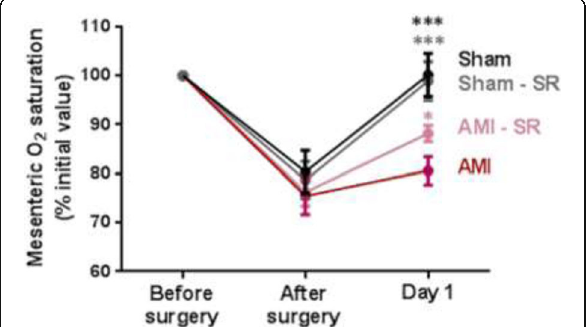
Fig. 1 (abstract 0008). Effect of AMI on mesenteric oxygenation (% of basal value)